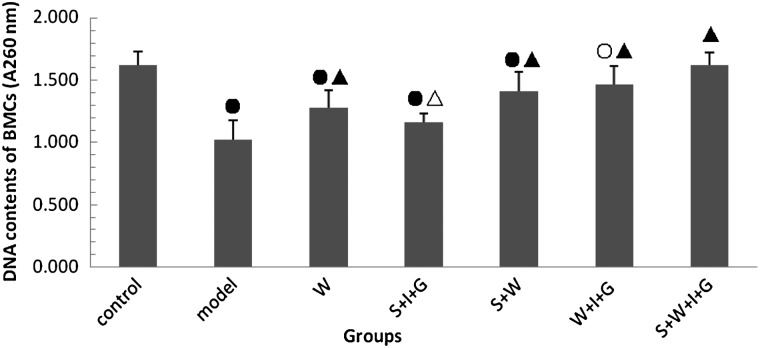
DNA contents of bone marrow cells in experimental mice. Compared with the control group: open circle: P < 0.05, closed circle: P < 0.01. Compared with the model group: open triangle: P < 0.05, closed triangle: P < 0.01.